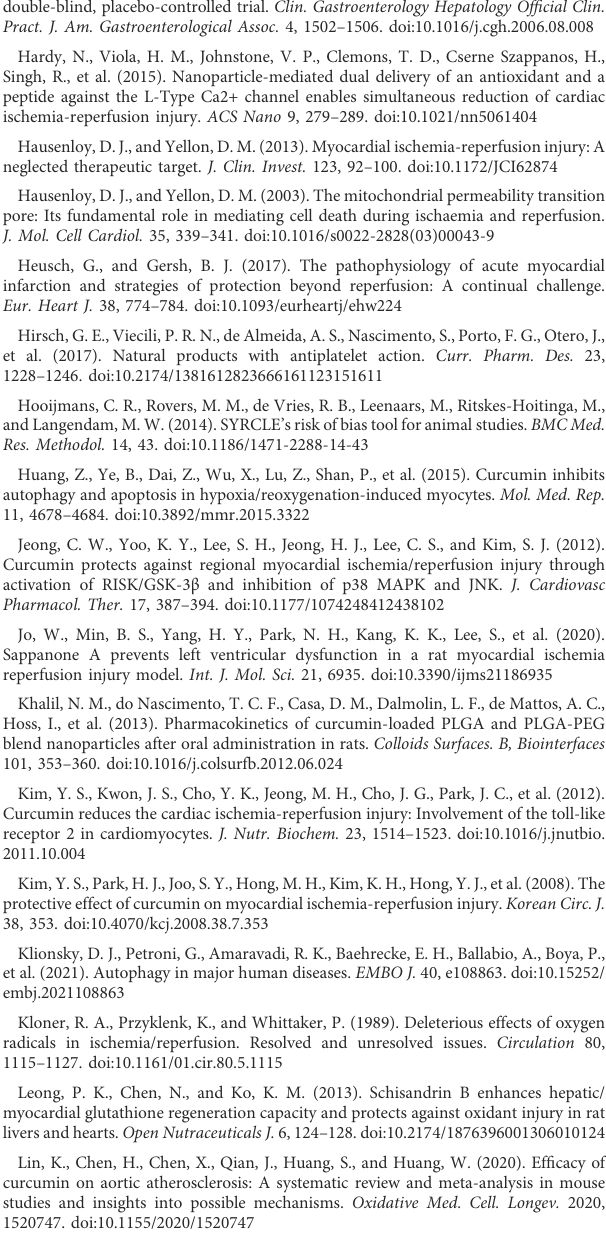
SUPPLEMENTARY FIGURE S1 Non-linear dose-response relationship between Napierian logarithm of RR and the intake of curcumin. The black lines are regression curves of Ln RR for different curcumin doses. The red line represents the optimal effect. Dots represent each of the studies. RR: ratio of means, equal to